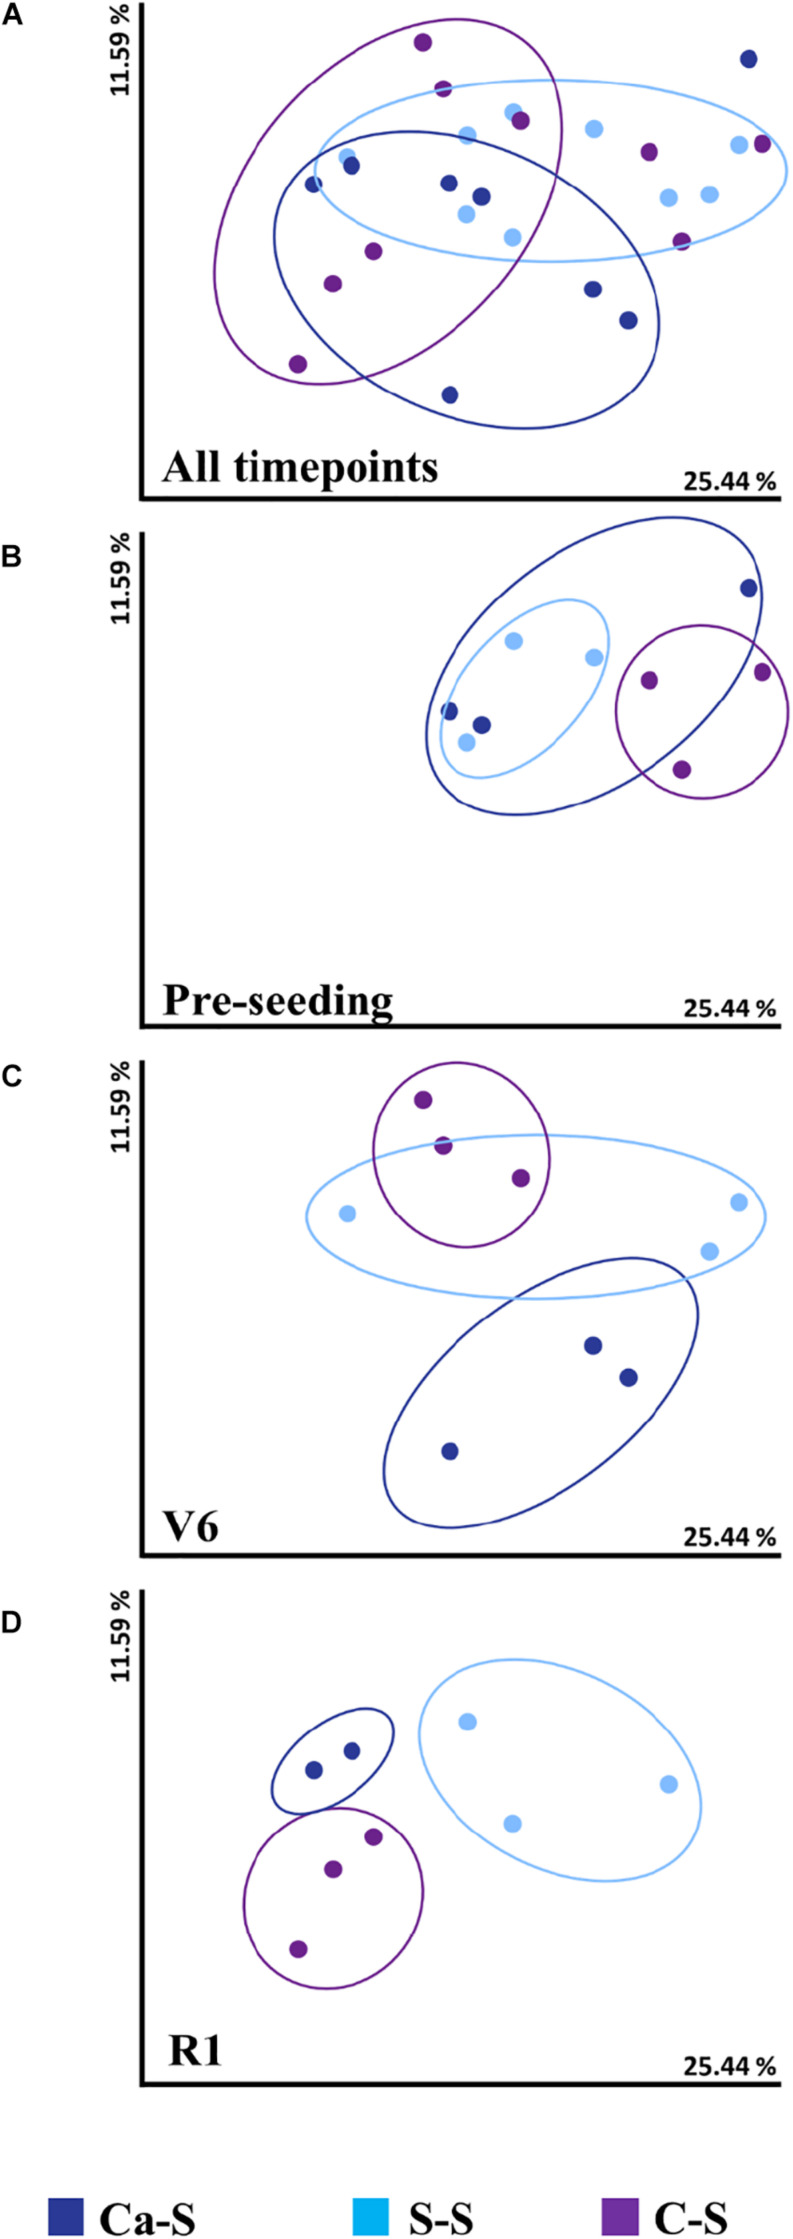
Influence of crop sequence on fungal species diversity in the bulk soil Principal coordinate analysis (PCoA), represented by the beta diversity metric – Weighted UniFrac, comparing the effect of crop sequence on microbial species diversity among treatments at all time points in the bulk soil. For each axis, the percent of variation is indicated. Dark blue dots, canola-soybean sequence (Ca-S); light blue dots, soybean-soybean sequence (S-S); purple dots, corn-soybean sequence (C-S). Each dot represents the average of three biological replicates and each biological replicate represents five pooled core soil samples. Comparison of cumulative fungal species diversity for all sequences collect at (A) all time-points (B) pre-seeding (C) V6, and (D) R1 soybean growth stages. Because of similarities in the data, some data points are overlapping.